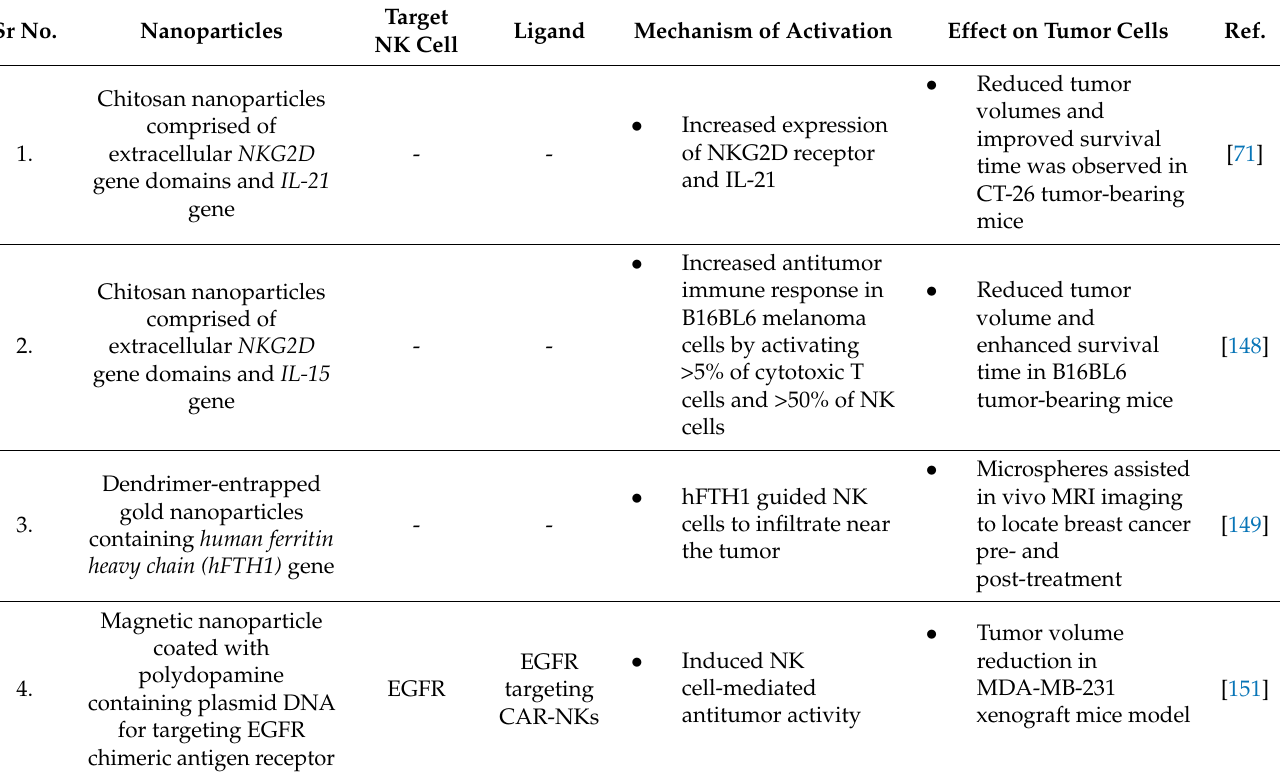
Table 5. Comprehensive information on nanoparticle-based genetic modification on NK